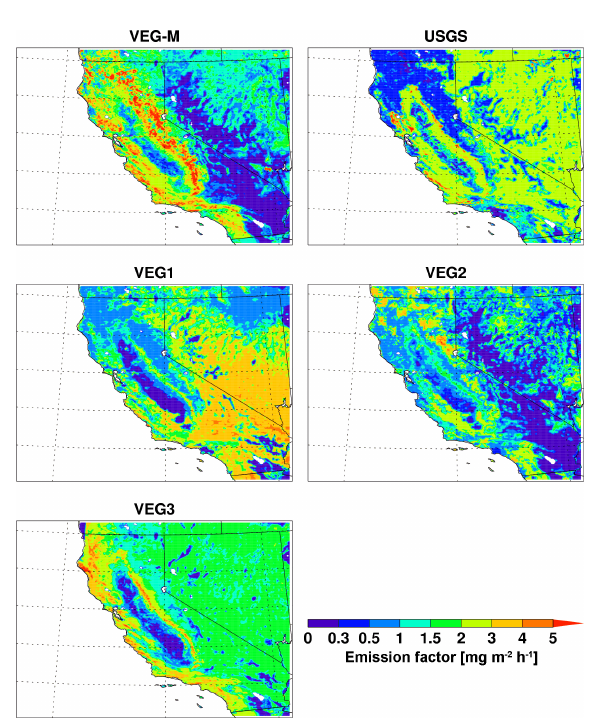
Figure 5. Spatial distribution of PFT-weighted mean biogenic iso- prene emission factor derived with the VEG-M in MEGAN v2.0 and the USGS, VEG1, VEG2 and VEG3 in MEGAN